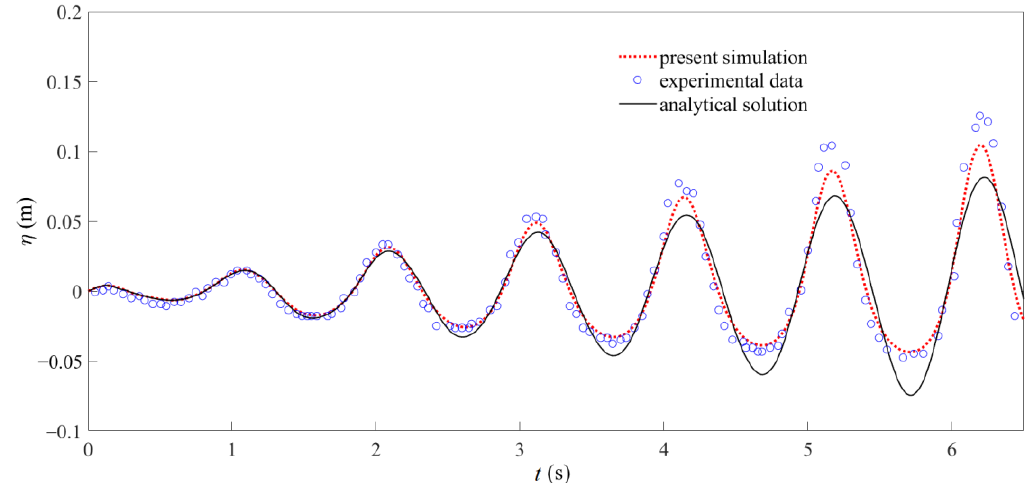
Figure 4. Comparison of the time history of free surface elevation at y = 0 between the results of the present simulation, experimental data of Liu and Lin [35] and analytical solution of Faltinsen [34].